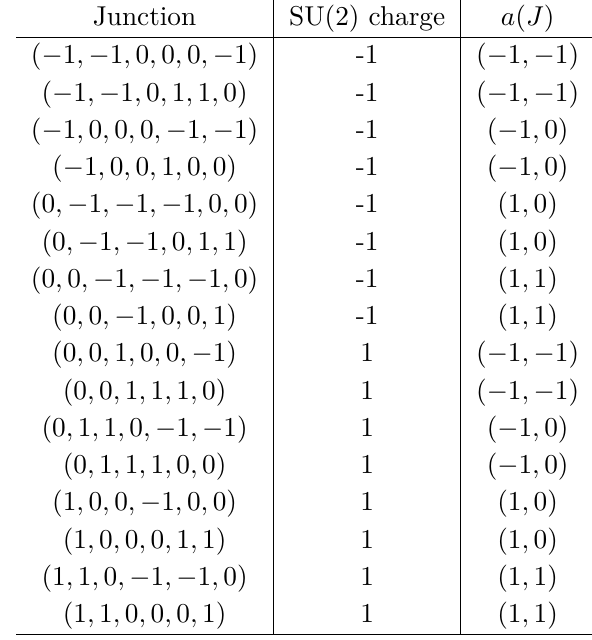
. The middle column is the 0